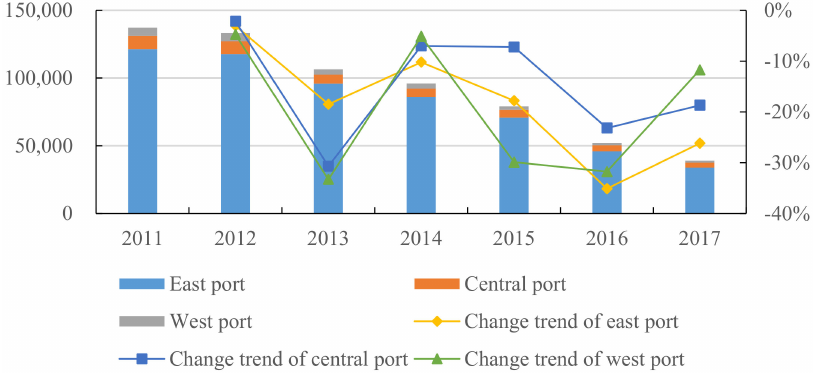
Figure 4. NO X emissions from ports in East, Central and West China (unit: